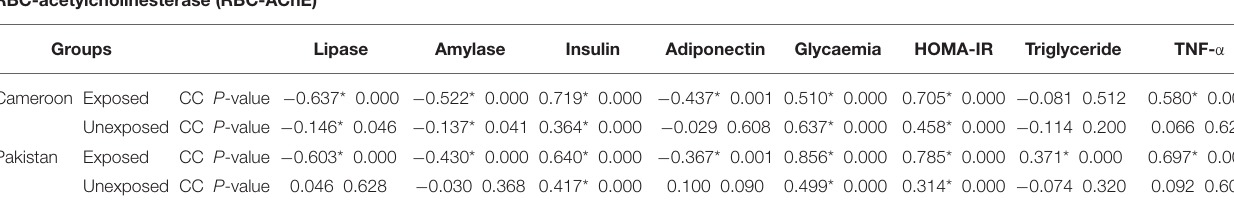
TABLE 4A | Correlation of Cholinergic Enzymes with all the biochemical parameters. RBC-acetylcholinesterase (RBC-AChE)